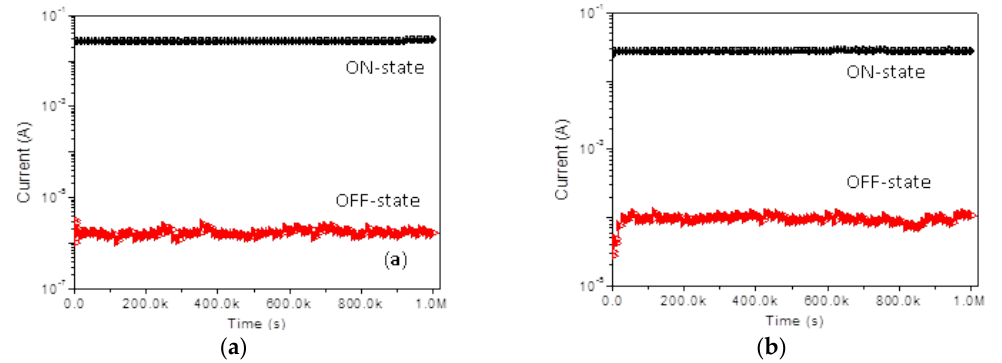
Figure 7. Retention ability of I ON and I OFF for ( a ) Ni/PMMA: 1 wt % GO/ITO and ( b ) Ni/PMMA: 3 wt % GO/ITO.